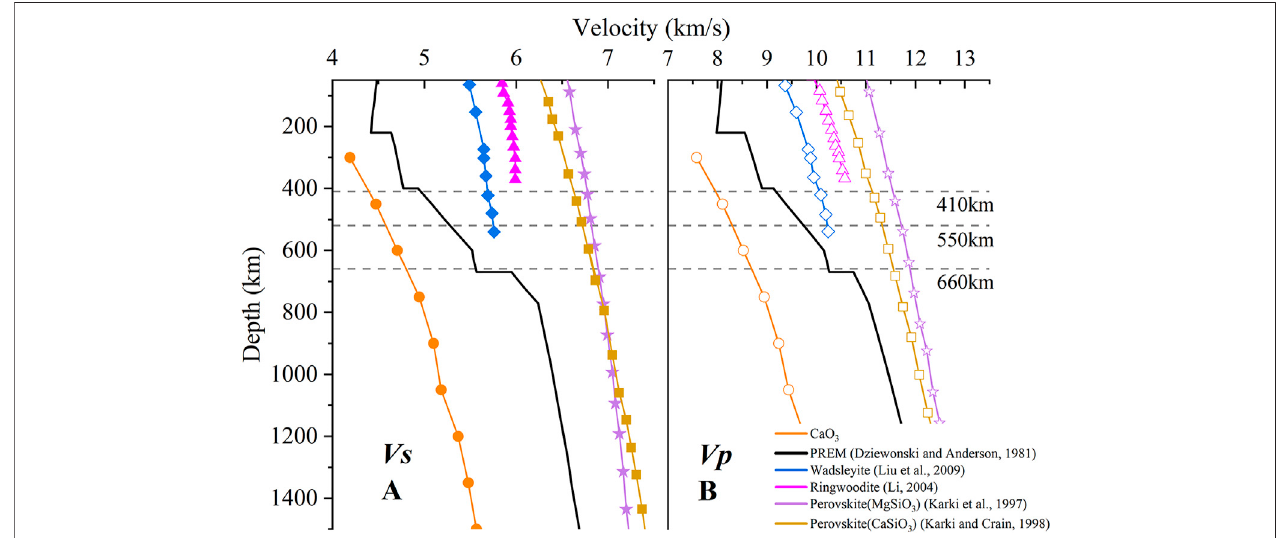
FIGURE 9 | Shear wave velocity (A) and compressional wave velocity (B) of CaO 3 , PREM model, wadsleyite, ringwoodite, perovskite (MgSiO 3 ), and perovskite (CaSiO 3 ) within 50 – 1500 km. The hollow legend represents Vs , the solid legend represents Vp , the orange circle represents CaO 3 , the solid black line represents the PREM model, the blue diamonds represent wadsleyite, the regular magenta triangles represent ringwoodite, the yellow squares represent perovskite (MgSiO 3 ), and the purple stars represent perovskite (CaSiO 3 ).